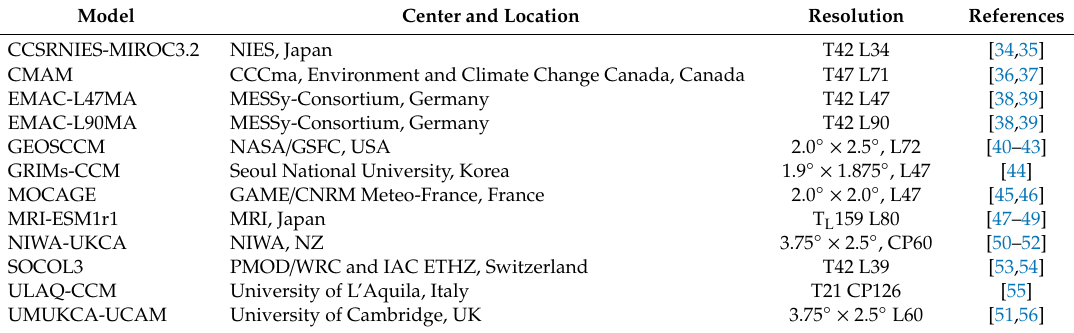
Table 1. List of Chemistry–Climate Model Initiative (CCMI) models used in this study. Model Center and